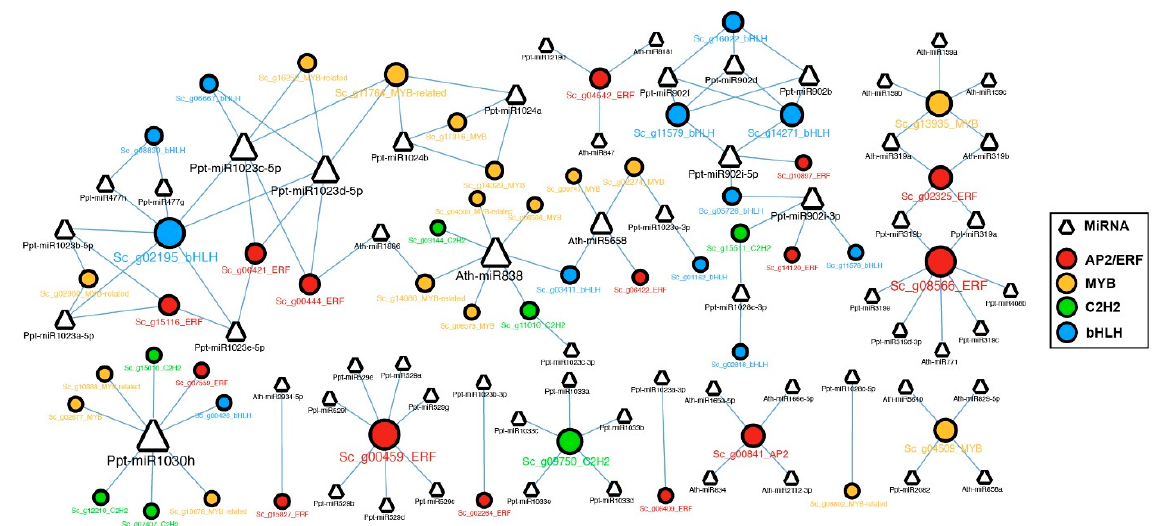
Figure 6. MicroRNA targeted four overrepresented TFs in S. caninervis . Cycle nodes indicate TFs and triangle nodes indicate microRNAs. Four TF family members were represented by different colors. Cycle and triangle sizes reflect the numbers of TFs or microRNAs.